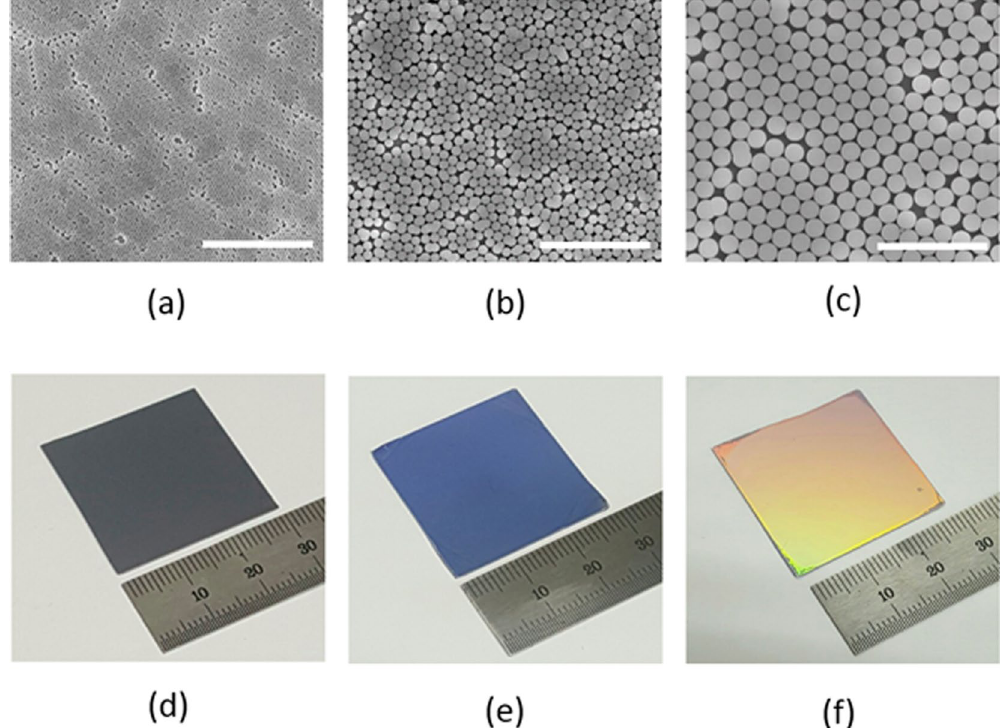
Figure 1. SEM images of silica bead self-assembled monolayers with different bead sizes of ( a ) 310 nm (P310), ( b ) 520 nm (P520), and ( c ) 960 nm (P960). Photo images the silica bead monolayers of ( d ) P310, ( e ) P520, and ( f ) P960 deposited on Si substrate of 3 cm × 3 cm. The scale bar in the SEM images is 5 μ